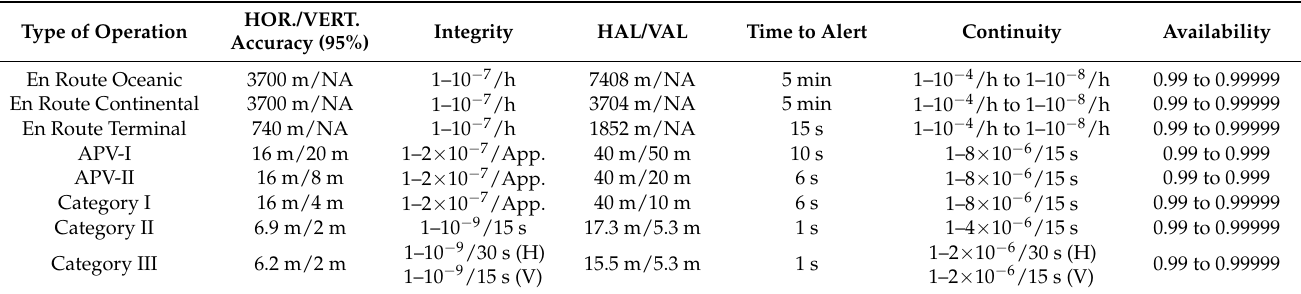
Table 1. Aviation GNSS signal-in-space performance requirements